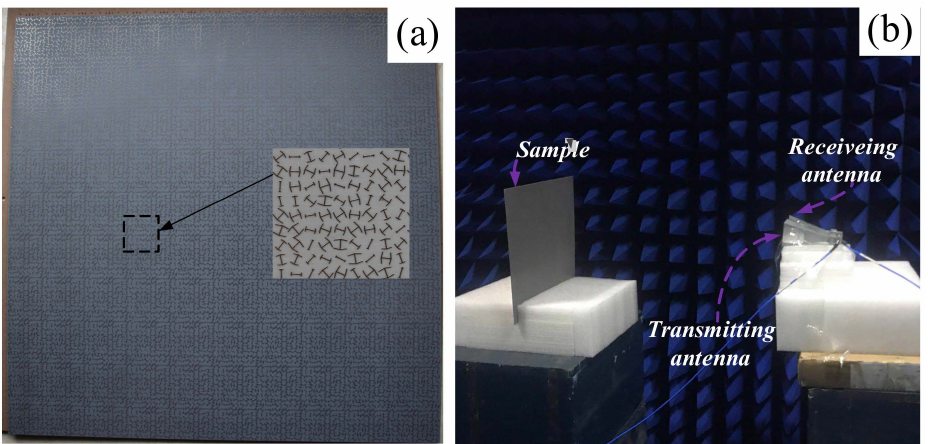
Figure 16. ( a ) The fabricated random 3-bit coding PCM; ( b ) experimental setup for verifying RCS reduction.